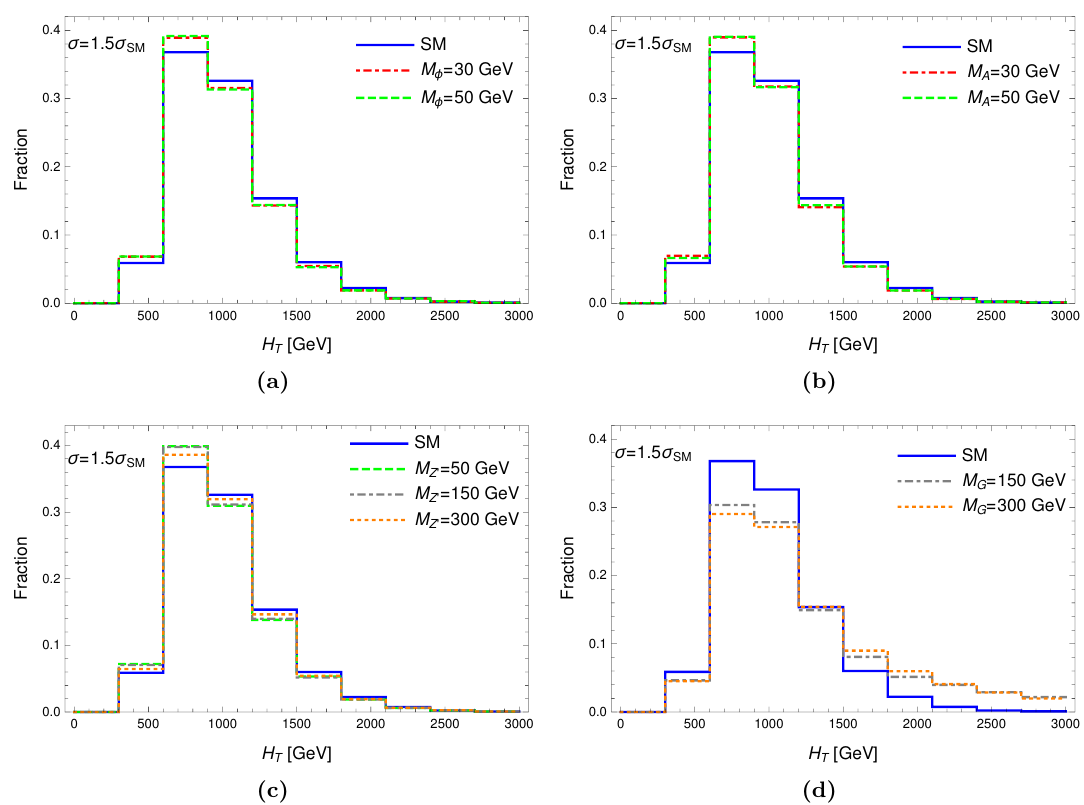
Figure 4. Distribution of the H T variable for the 2LSS channel after preselection (see text for details), normalized to unit area. Shown are the predictions for the SM (blue) and the tight benchmark points (i.e. giving (cid:27) = 1 : 5 (cid:27) SM ) of the NP models considered: (a) Scalar, (b) Pseudo- scalar, (c) Z 0 , and (d) Graviton. The distinctive behavior in the Graviton is due to the symmetry in one of its main Feynman diagram, as explained in the text. Analogous results for the loose benchmark points (i.e. giving (cid:27) = 2 (cid:27) SM ) are shown in (cid:12)gure 8 in appendix